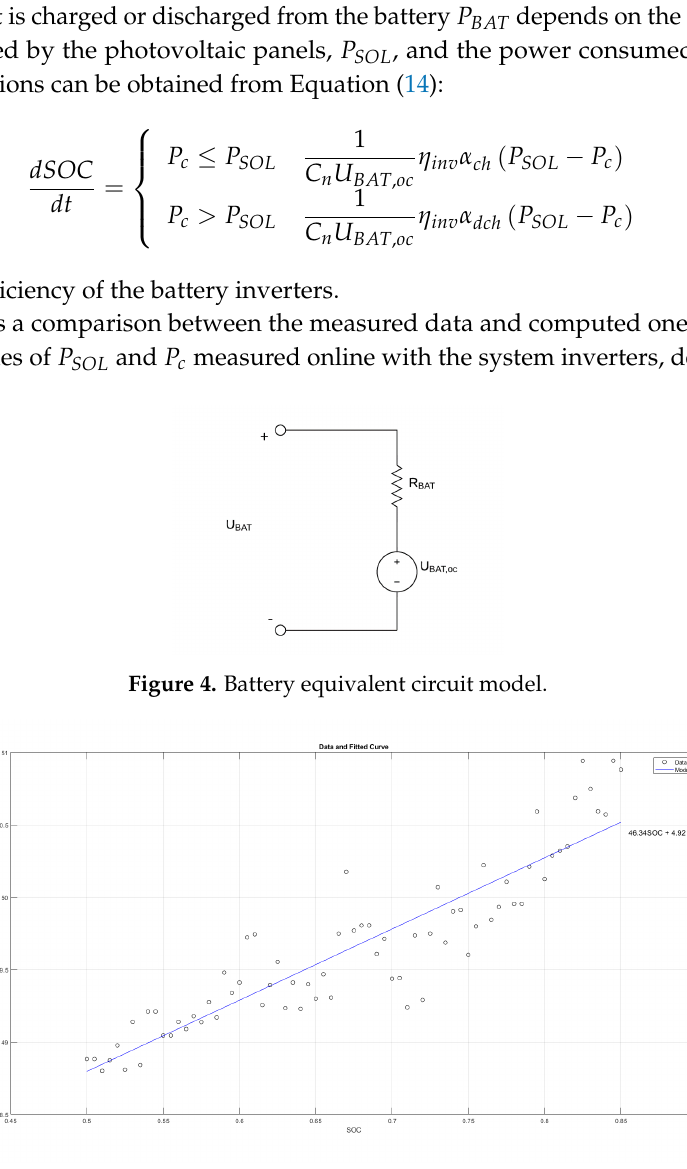
Figure 5. Evolution of the battery open circuit voltage as function of SOC (state of charge). The set of data points have been fitted with a linear